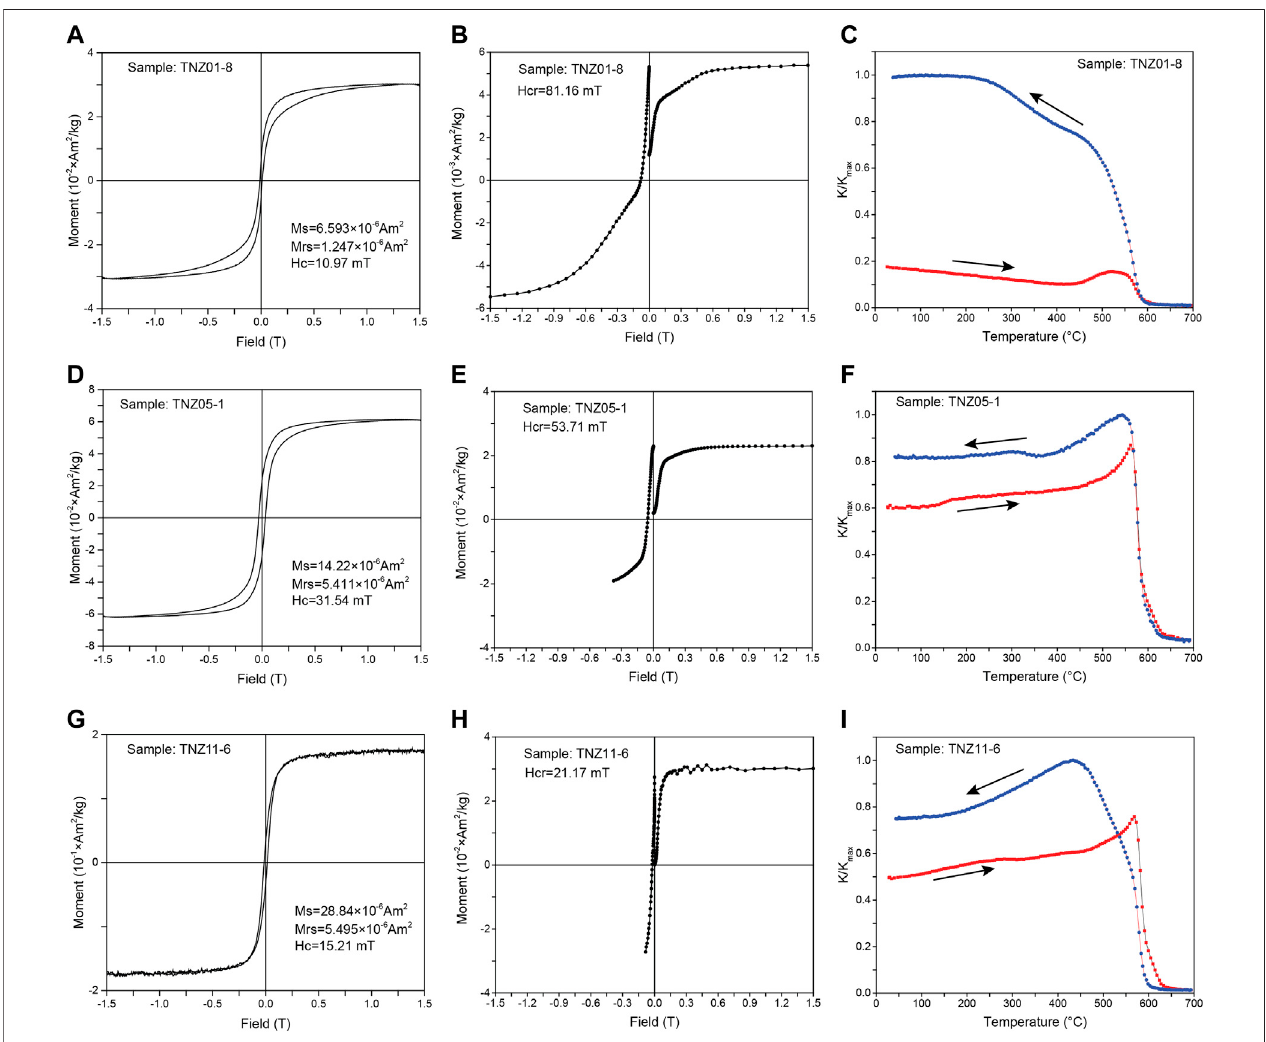
FIGURE 4 | Rock magnetic results for selected samples from the Zonggei Formation volcanic rocks. (A,D,G) hysteresis loops and detailed values of hysteresis parametersforrepresentativesamples; (B,E,H) ,IRMacquisitioncurvesandback fi elddemagnetizationofsaturatedIRMforrepresentativesamples; (C,F,I) temperature dependence of magnetic susceptibility curves (heating-cooling cycle from room temperature up to 700 ° C).